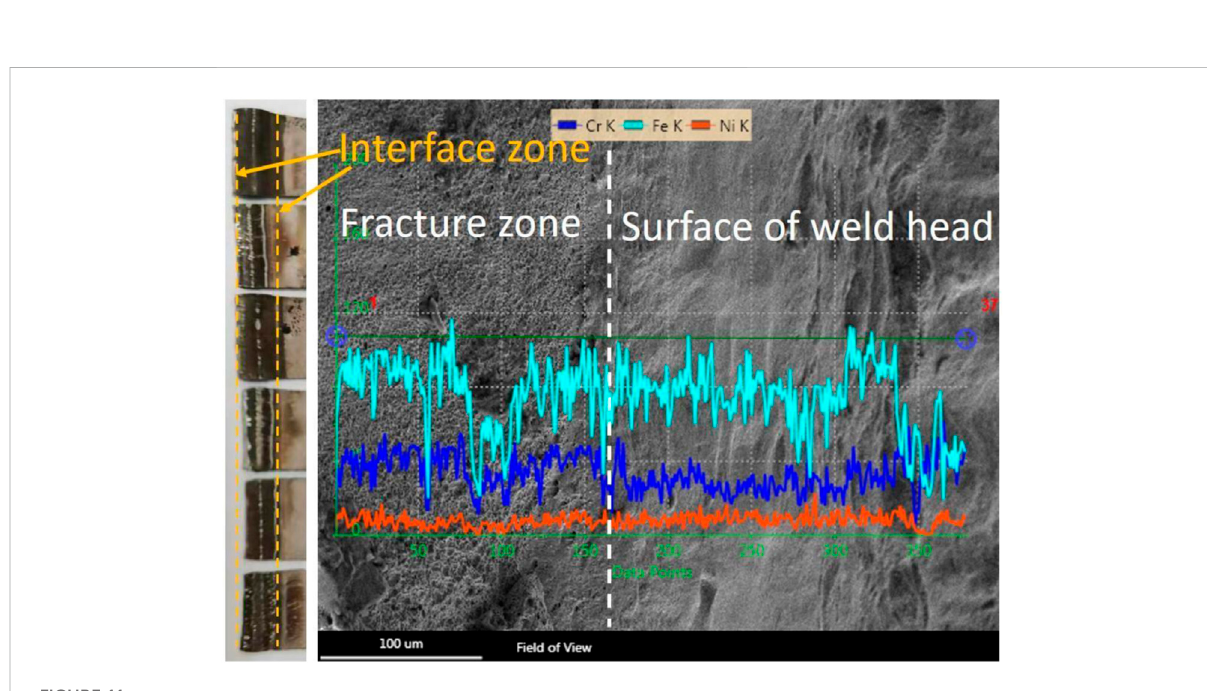
FIGURE 11 EDS analysis of the fracture